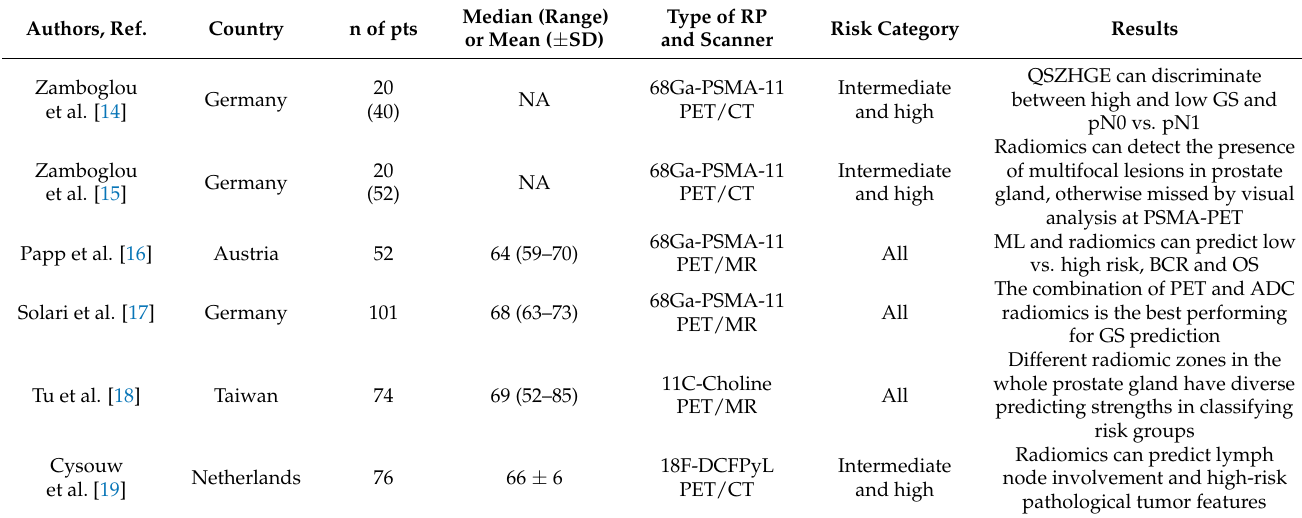
Table 1. Clinical characteristics of the selected